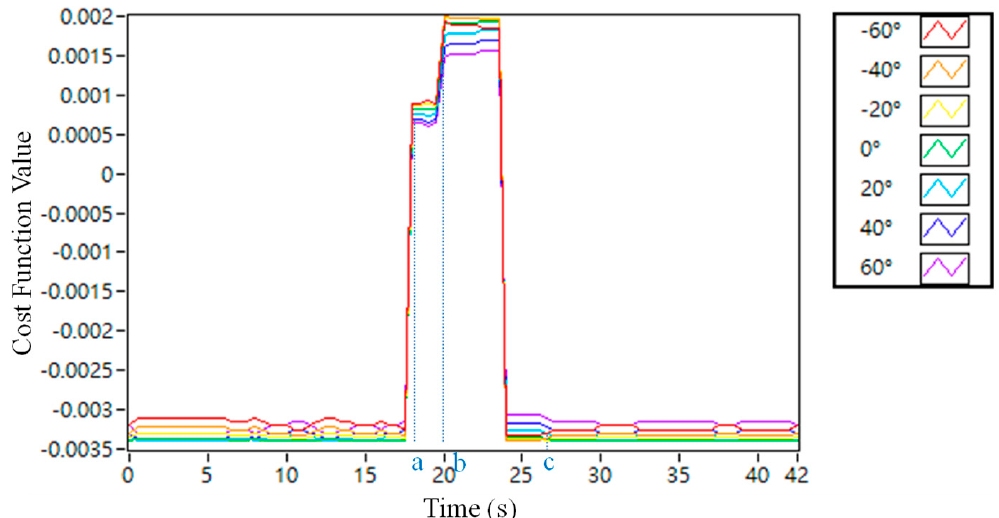
Figure 10. Simulated cost function values. The horizontal axis is time (s). The vertical axis is the cost function value. The points of the scan map are marked by blue lower-case letters.